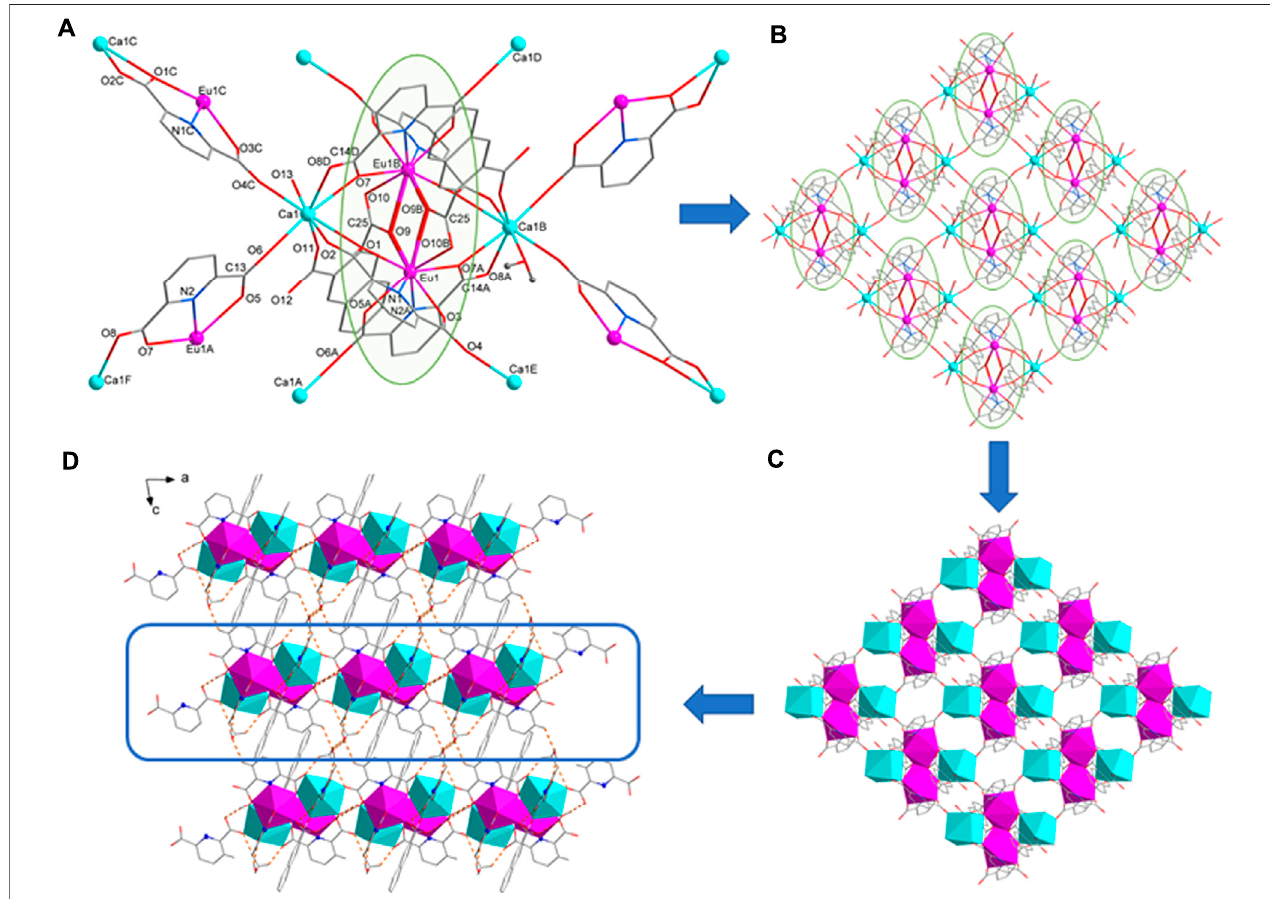
FIGURE1|(A) Thecoordination environment ofEu1and Ca1 ion. (B) 2Dlayer structure of 1 . (C) 2D layerdiamond structure of 1 . (D) Thehydrogen bond packing diagrams of 1